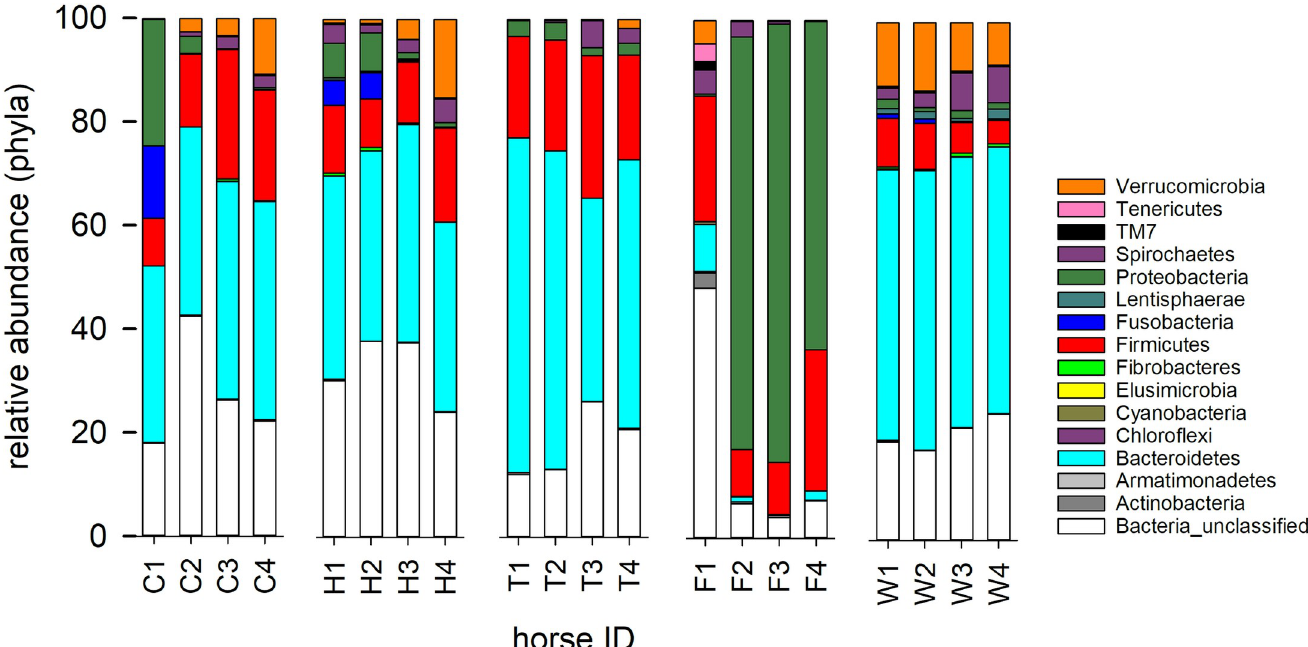
Fig 3. Phylum level taxonomy of 5 FMT recipients. Samples are labelled by horse as shown in S3–S5 Tables. The number indicates the day of treatment.